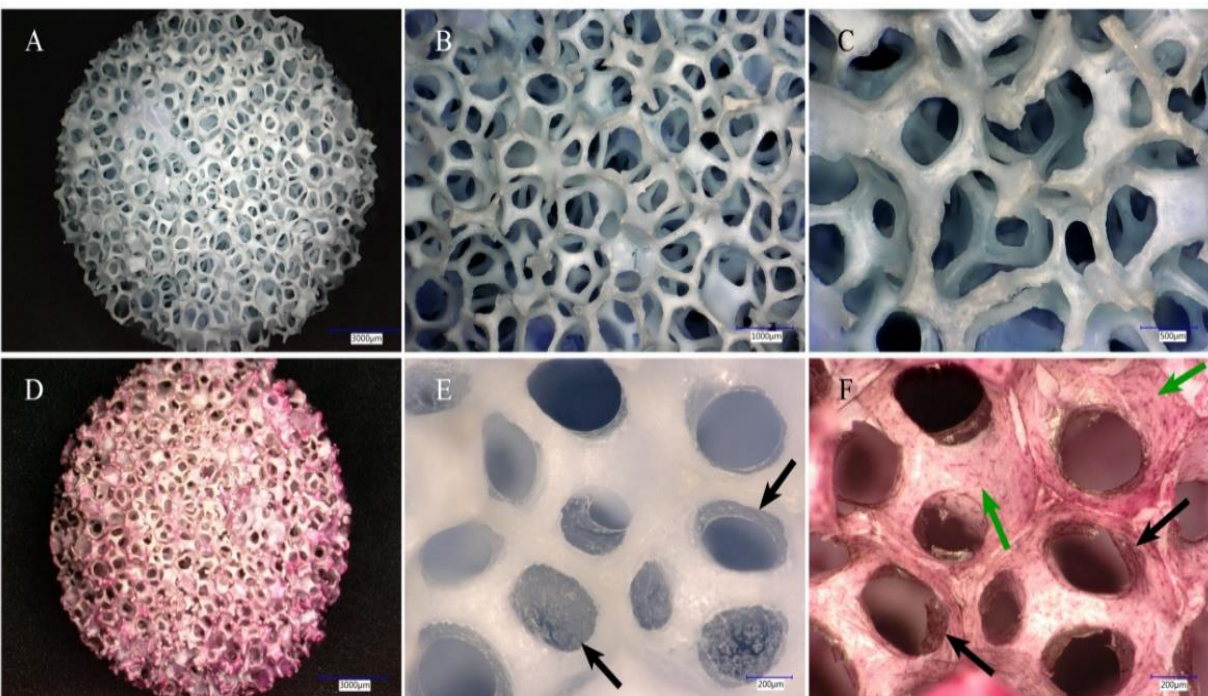
Figure 5. The morphological structure of the untreated scaffold ( A – C ) and representative 3D digital micrographs of hADSC-colonized scaffold cultured for 28 days ( D – F ). (A × 20, B × 50, C × 100): The 3D digital microscope images show the scaffold ’ s 3-D, highly porous structure with ordered inter- connected pore channels. (D × 20): Haematoxylin and Eosin (H&E) staining of hADSC-seeded 3D scaffold: after 28 days of incubation, the entire hADSC-colonized scaffold was thoroughly stained to red and blue with H&E. (E × 200): It is exhibited that the pores were averagely distributed with stem cells (black arrows). (F × 200): H&E-stained hADSCs located in the pores (black arrows) and on the scaffold wall surface (green arrows) could still be clearly observed, even though a large fraction of cells was damaged during the process of staining. E and F were taken in the same position of the scaffold.